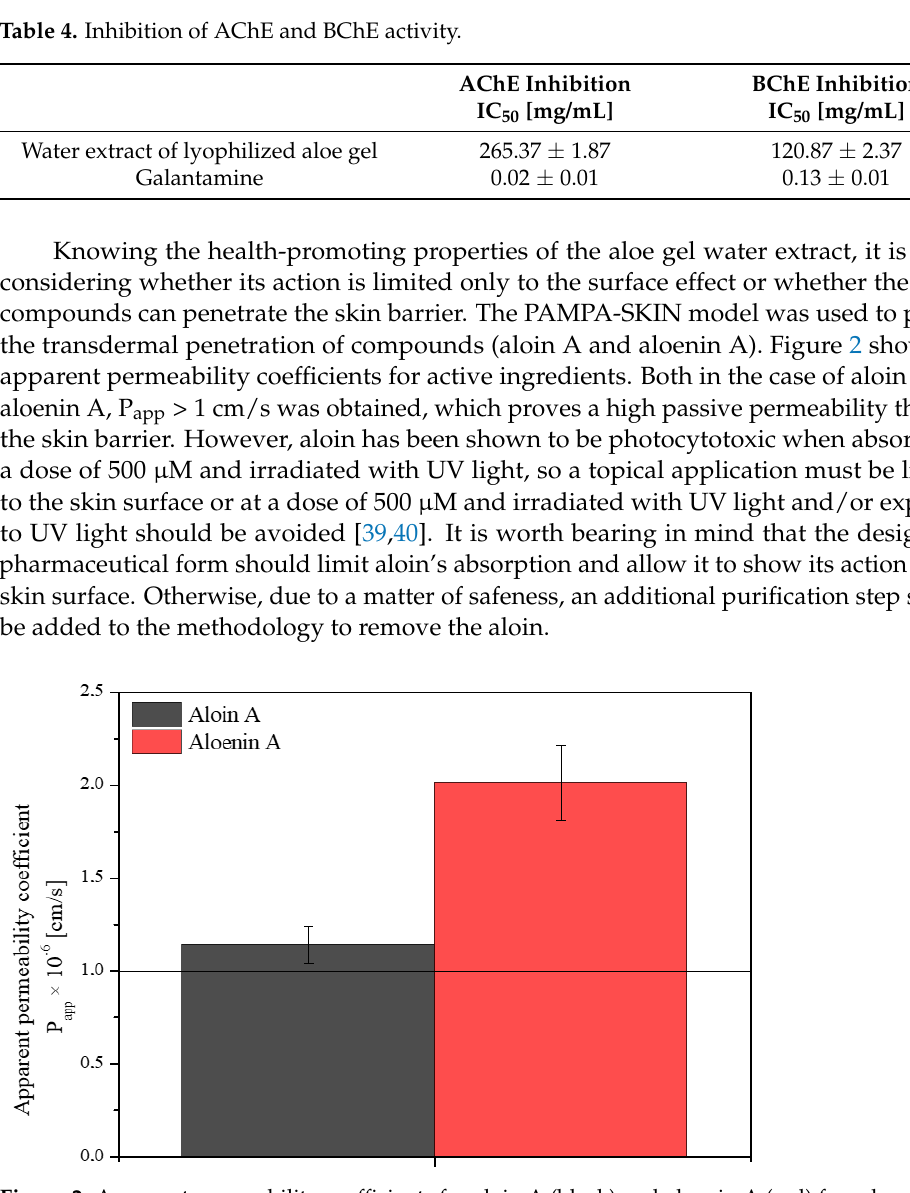
Figure 2. Apparent permeability coefficients for aloin A (black) and aloenin A (red) from lyophilized aloe gel using the SKIN